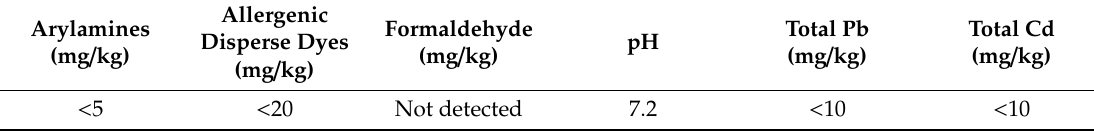
Table 2. Hazardous material contents of fabricated textile sensor based on mixed dyes.